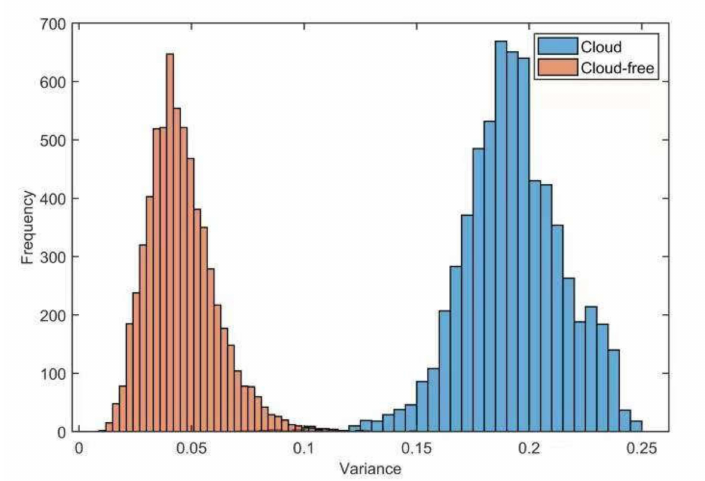
Figure 7. NDSI variance in snow and common